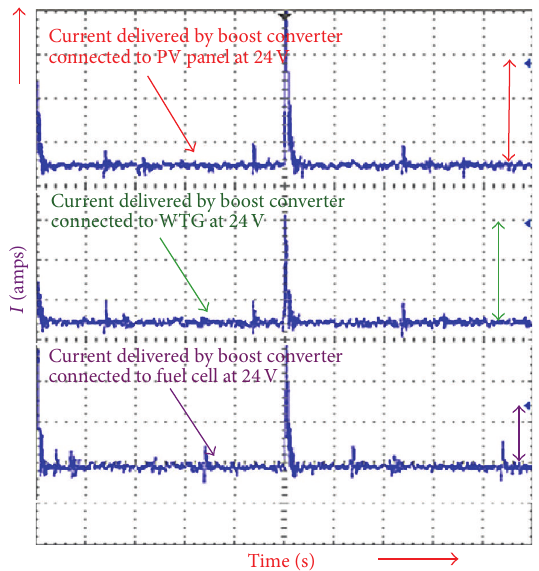
Figure 31: Current delivered by the sources in meeting the load